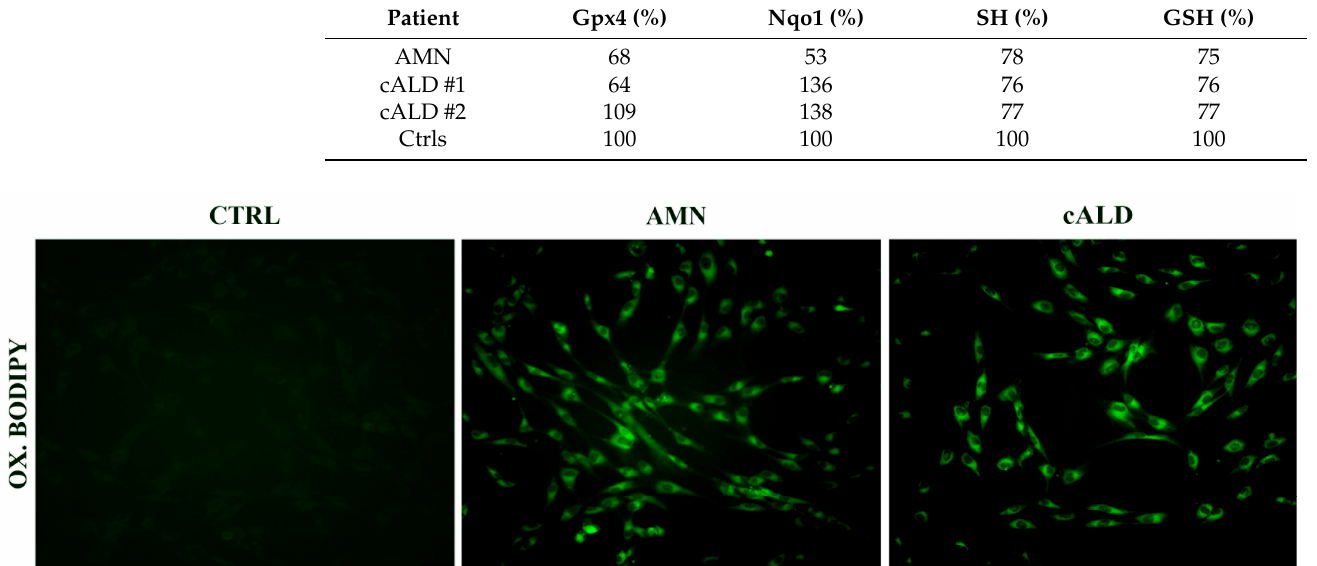
Figure 3. Representative images of lipid peroxides staining (green), detected by the fluorescent lipophilic Bodipy-C11 sensor, of X-ALD patients’ fibroblasts (scale bar = 100 µ m).